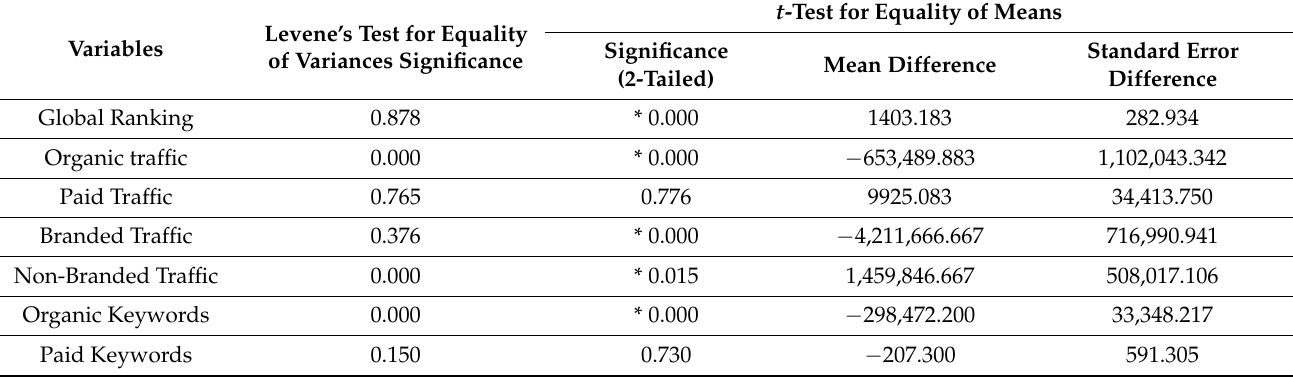
Table 2. Independent sample t -tests results between the pre-COVID and COVID 1st 12-month period data